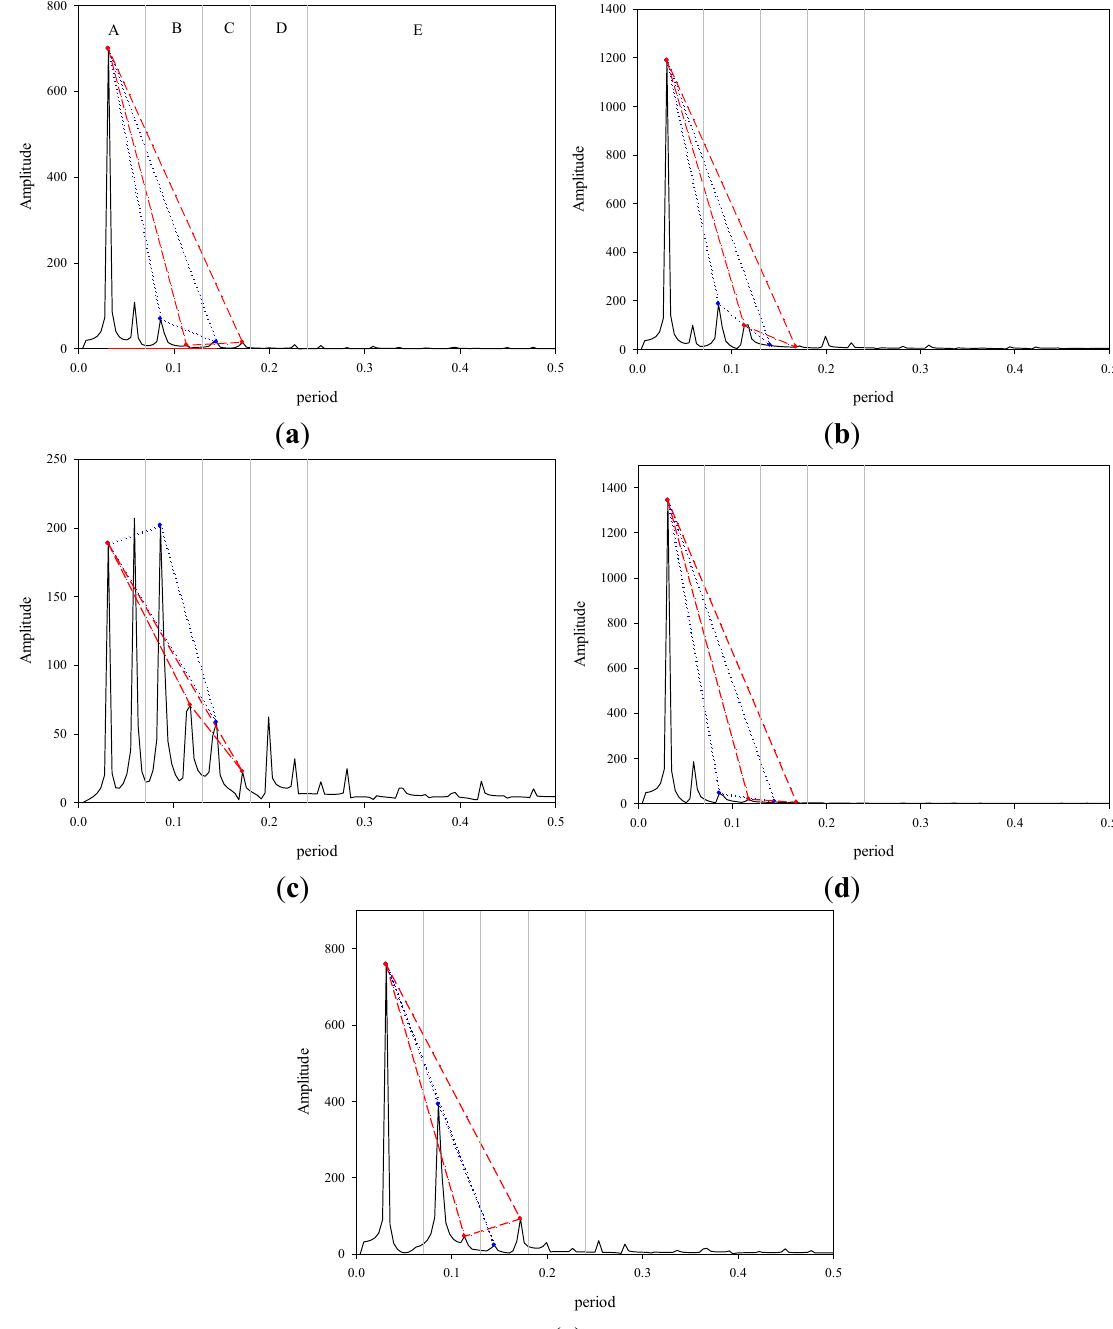
Figure 3. Signal operation diagram. ( a ) Mean value spectrum; ( b ) Case 1; ( c ) Case 2; ( d ) Case 3; ( e ) Case